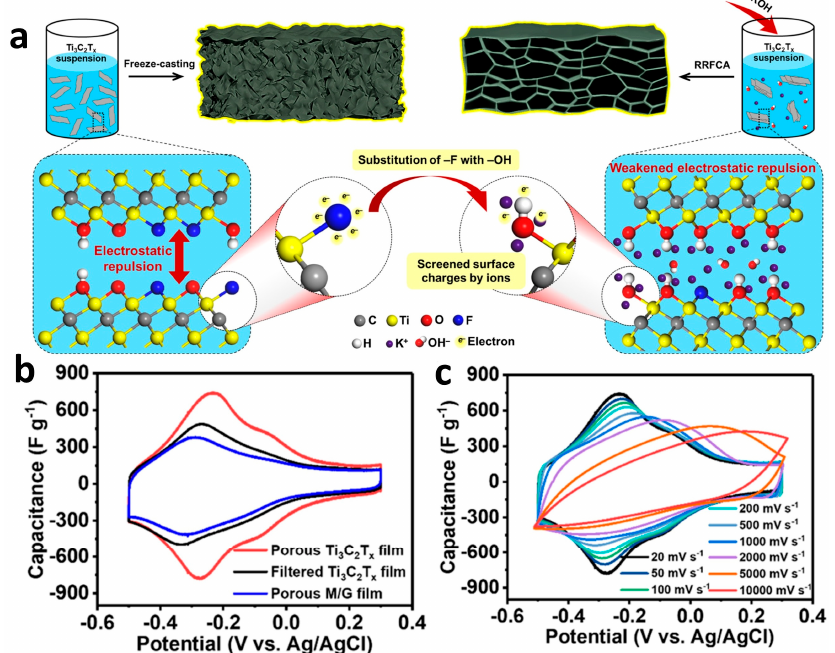
Figure 7. ( a ) Comparison of conventional freeze-casting and reduced-repulsion freeze-casting assembly processes. ( b ) CV curves of porous M/G film, filtered Ti 3 C 2 T x film, and 3D porous Ti 3 C 2 T x film at 20 mV s − 1 . ( c ) CV curves of 3D porous Ti 3 C 2 T x film at the different scan rates ranging from 20 to